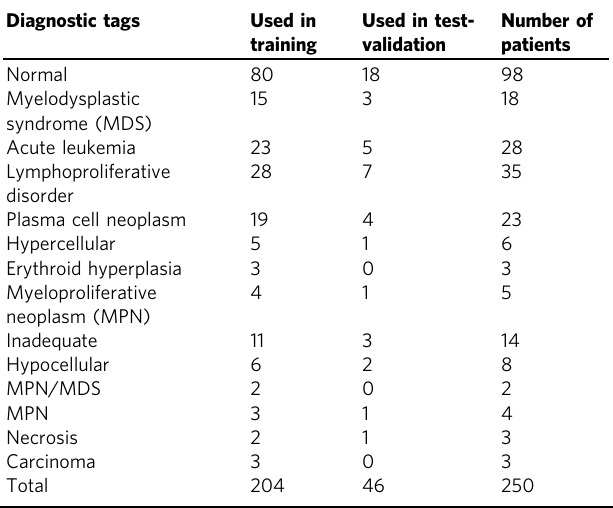
Table 1 Diagnostic tags and the number of patient WSI used for training and test-validation in each category for the ROI detection